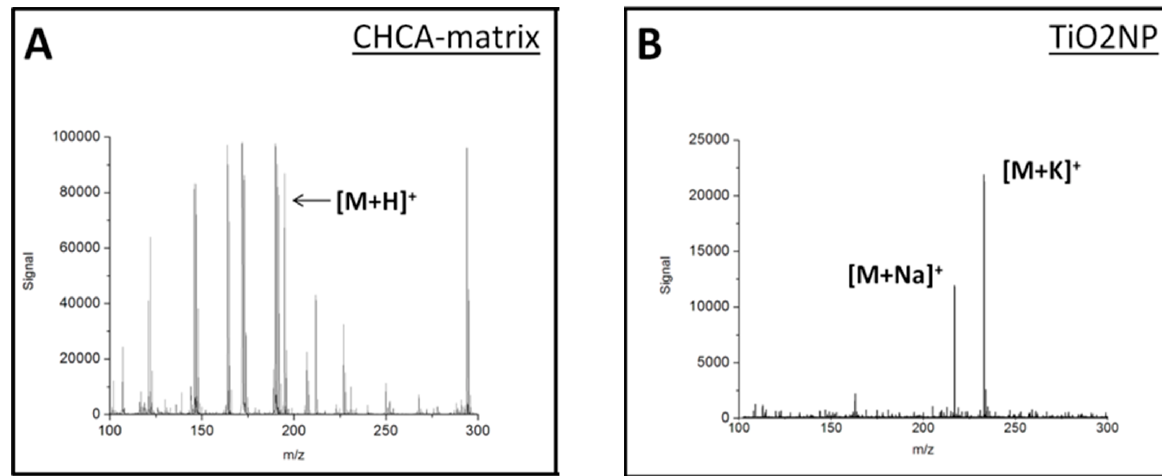
Figure 1. Caffeine on target. CHCA matrix ( A ) vs. TiO 2 NP ( B ). On the MALDI target, 1 µ L of nanoparticle suspension was drop-cast (0.5 mg/mL, 0.5 µ g spotted) and 2.5 nmol of caffeine (1 µ L, 2.5 mM water solution) was added. The mass spectrum in ( A ) is dominated by matrix ions in the low mass range, while nanoparticles in ( B ) produce a cleaner spectrum, favoring cationization over protonation.